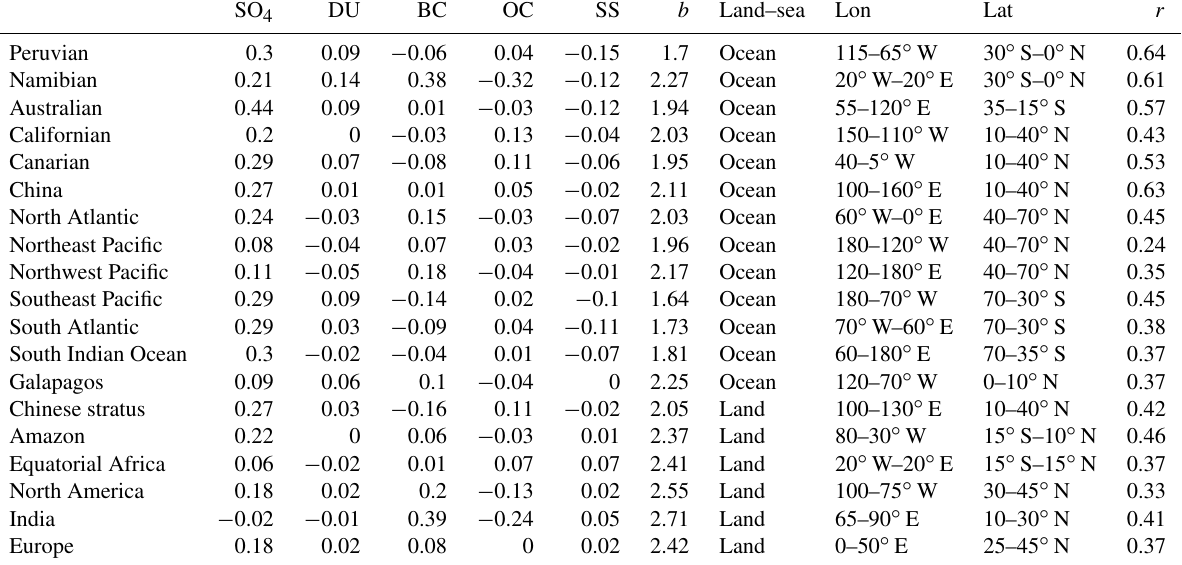
Table 1. Details of the regions considered in this study (see also Fig. 1). For each region the coefficients relating CDNC to predictors from Eq. (1) are shown along with the correlation coefficient of the regression model in that region. The constant term in the regression is shown under b . The latitude–longitude bounding box of each region is shown and it is noted if data are restricted to being over land or